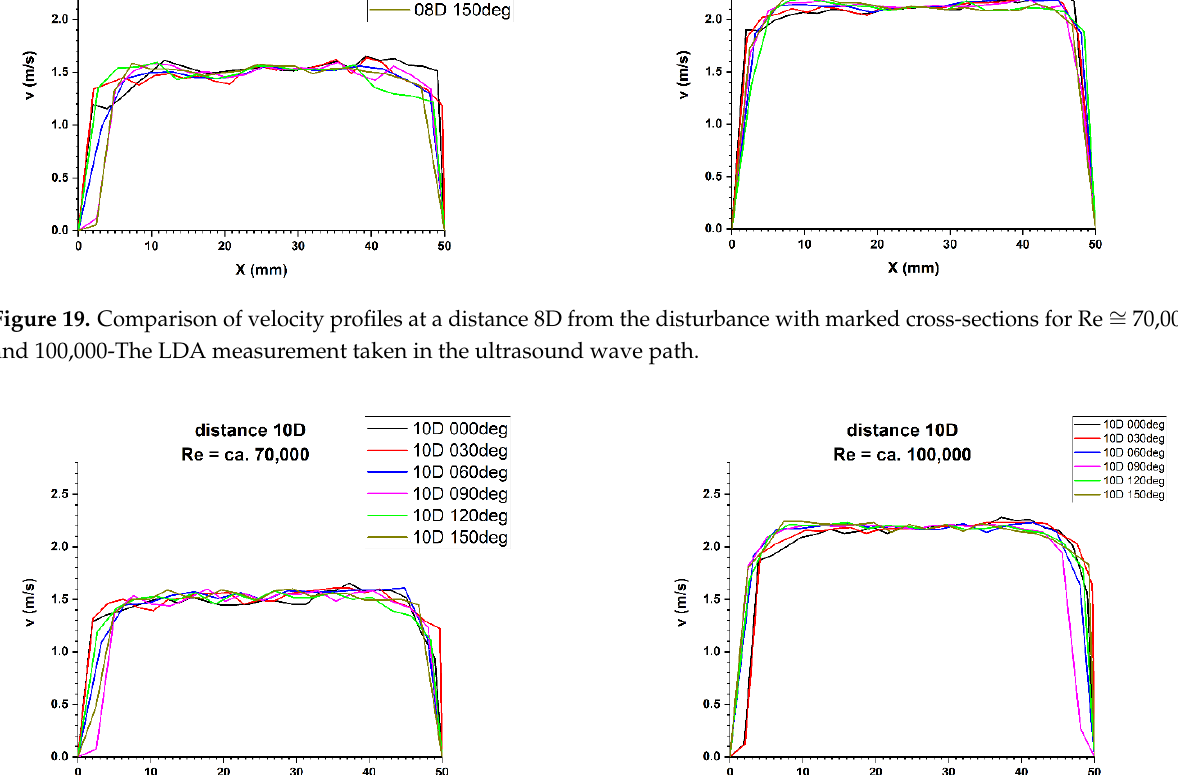
Figure 20. Comparison of velocity profiles at a distance 10D from the disturbance with marked cross-sections for Re ≅ 70,000 and 100,000-The LDA measurement taken in the ultrasound wave path.